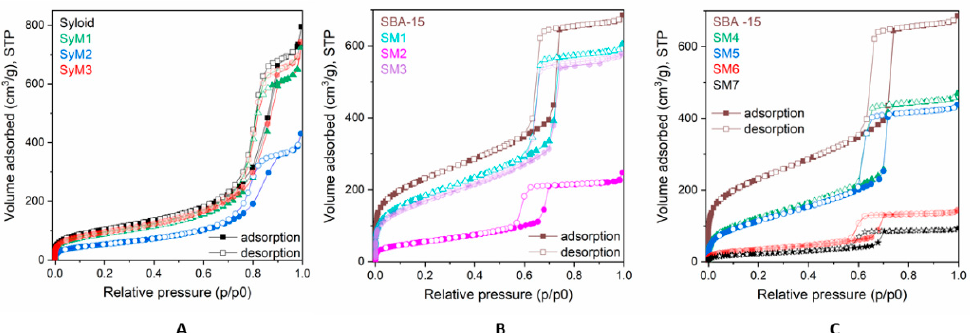
Figure 1. Adsorption isotherms of metronidazole–MSM materials; ( A ): Syloid samples, ( B ) and ( C ): SBA-15 samples. ( C ): SBA-15